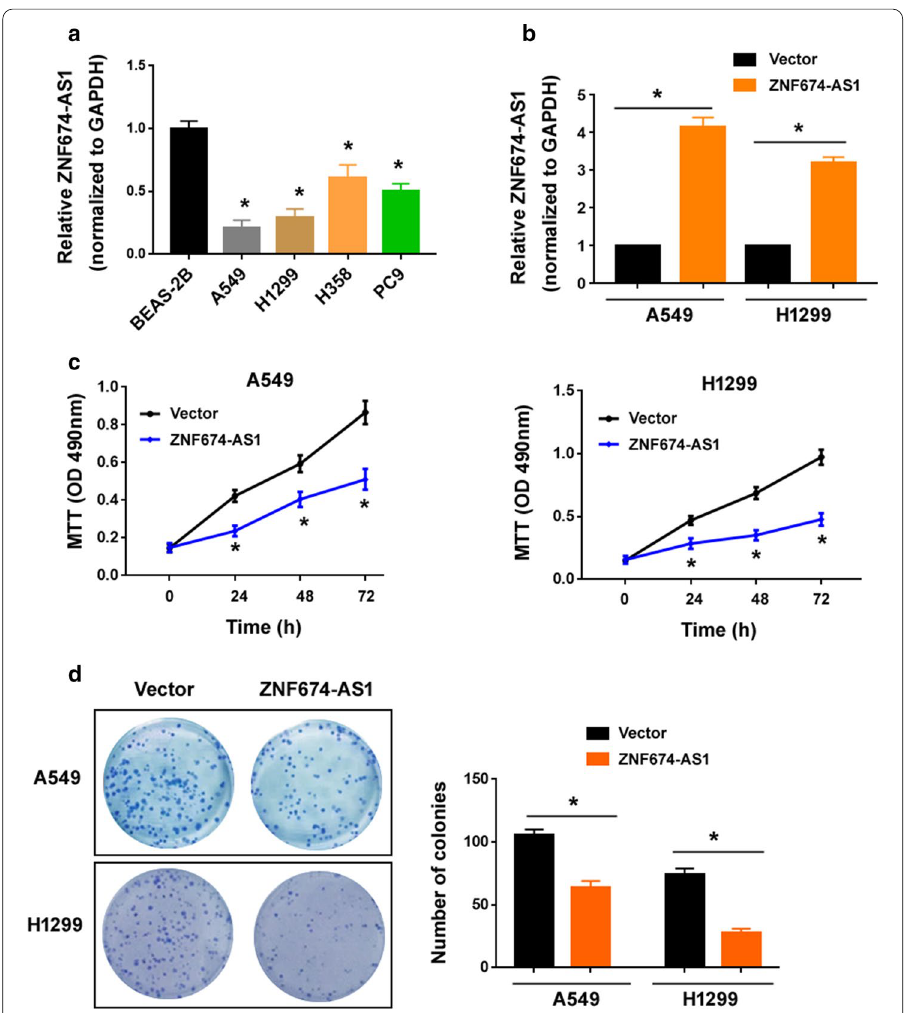
Fig. 2 ZNF674-AS1 suppresses NSCLC cell proliferation and colony formation. a Expression of ZNF674-AS1 in indicated cell lines. * P < 0.05 compared to BEAS-2B cells. b Overexpression of ZNF674-AS1 in both A549 and H1299 cells. c As determined by MTT assay, NSCLC cell growth was suppressed by overexpression of ZNF674-AS1. d Colony formation assay showed that ZNF674-AS1 suppressed colony formation capacity of NSCLC cells. * P < 0.05 vs.